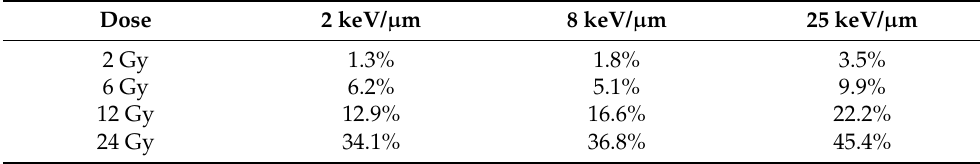
Table 2. Maximum relative difference between fixed-reference RBE and no-repair RBE for the analysis shown in Figures 1 and 2. The maximum relative difference was determined at the highest dose rate analyzed (saturation